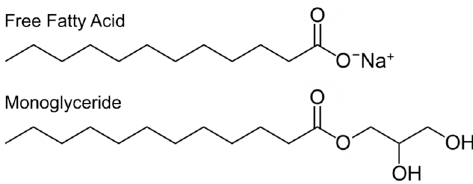
Figure 1. Chemical structures of a representative free fatty acid and monoglyercide.